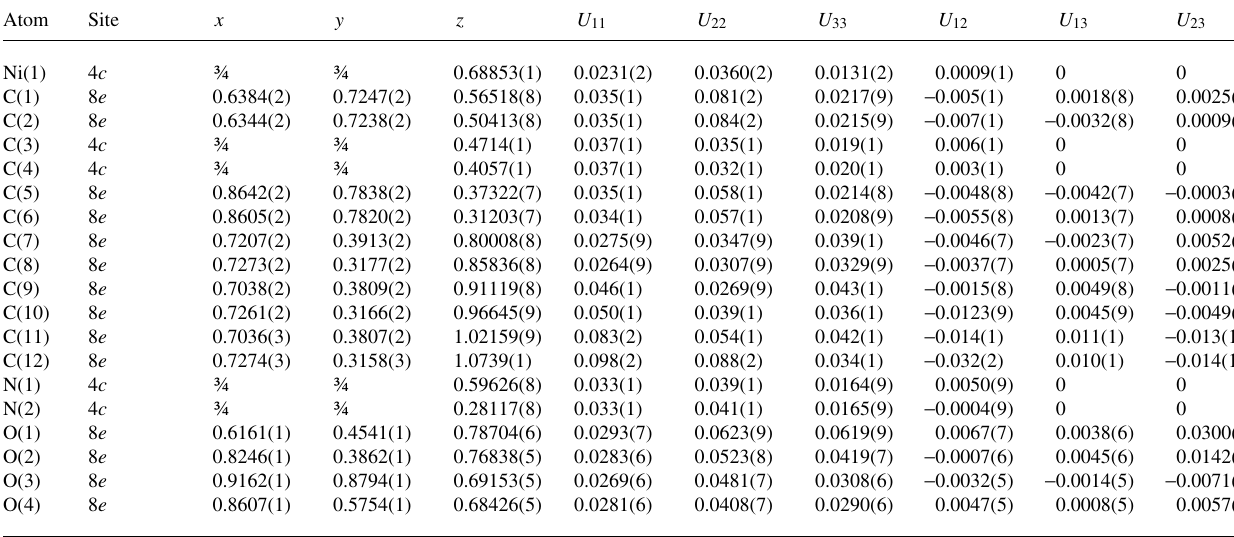
Table 3. Atomic coordinates and displacement parameters (in Å 2 ) .